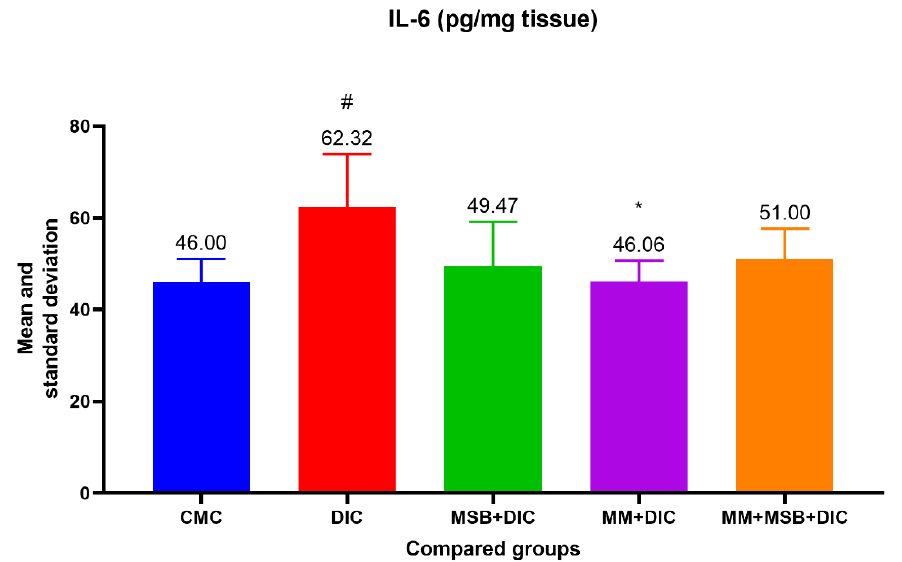
Figure 3. Mean value and standard deviation of IL-6 between analyzed groups. Group I-CMC, negative control group; group II-DIC, disease control group; group III-MSB+DIC, group receiving MegaSporeBiotic; group IV-MM+DIC, group receiving MegaMucosa; group V-MM+MSB+DIC, group receiving MegaSporeBiotic and MegaMucosa; *, p < 0.05 compared with group II (DIC); #, p < 0.05 compared with group I (CMC).